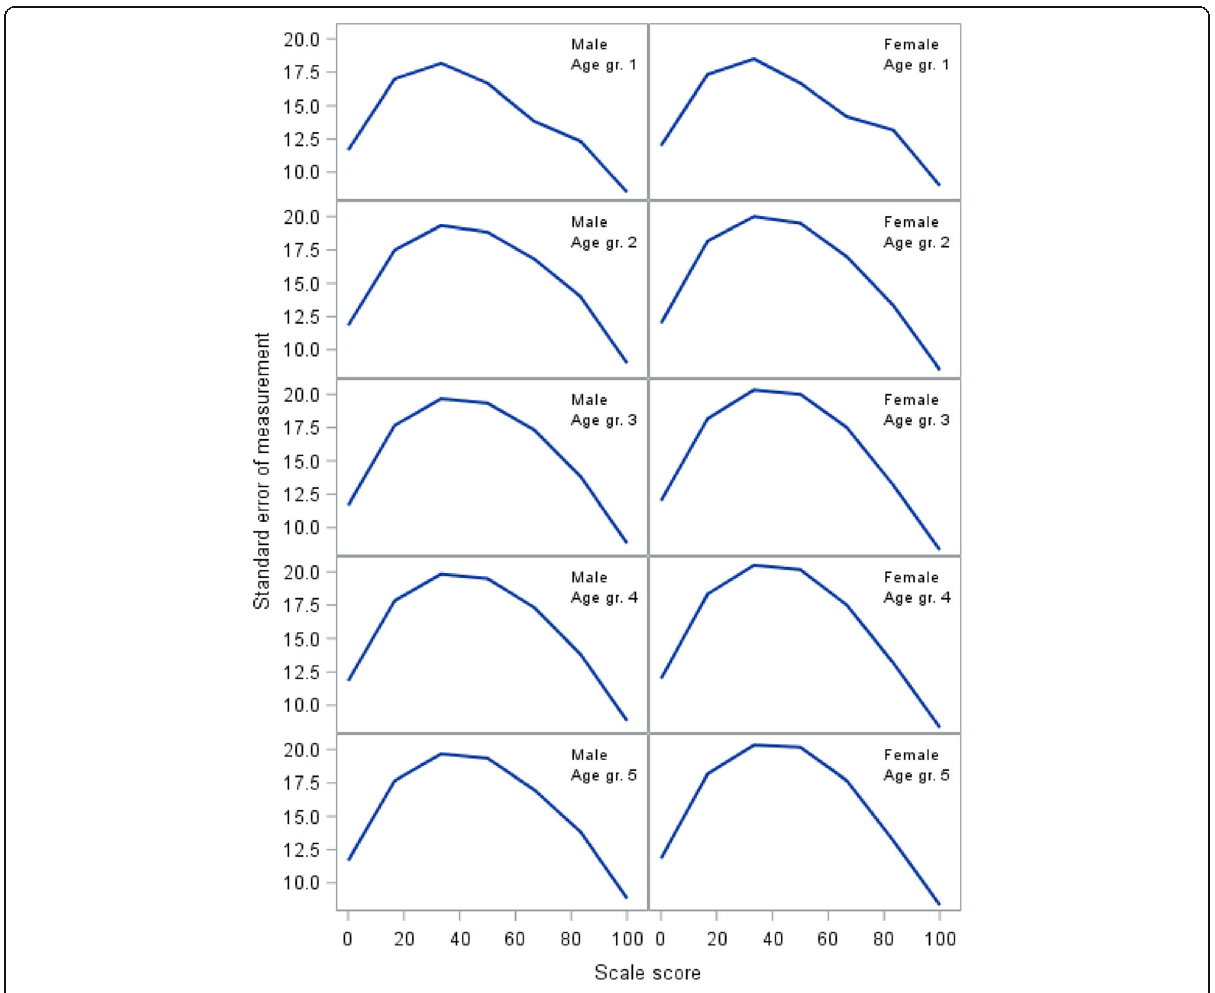
Fig. 4 Standard error of measurement for the Family Life